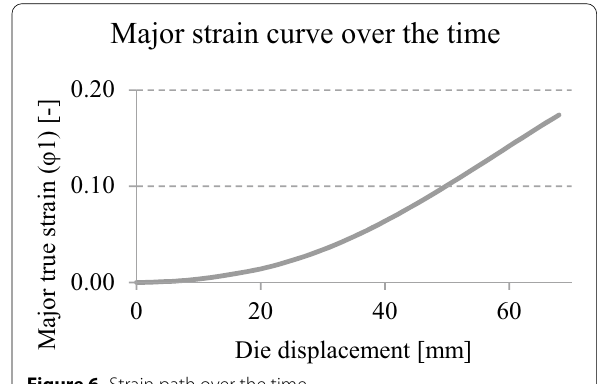
Figure 6 Strain path over the time